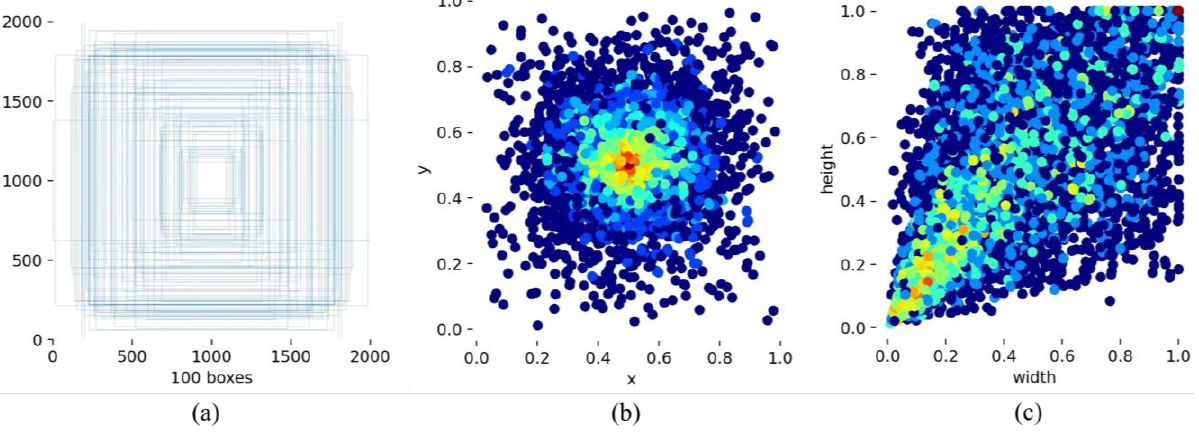
Figure 9. Overview of COD10K dataset. ( a ) The distribution of the first 100 bounding boxes; ( b ) The abscissa and ordinate of the center point of the camouflaged object; ( c ) The proportion of the bounding boxes of the camouflaged object in the image size.